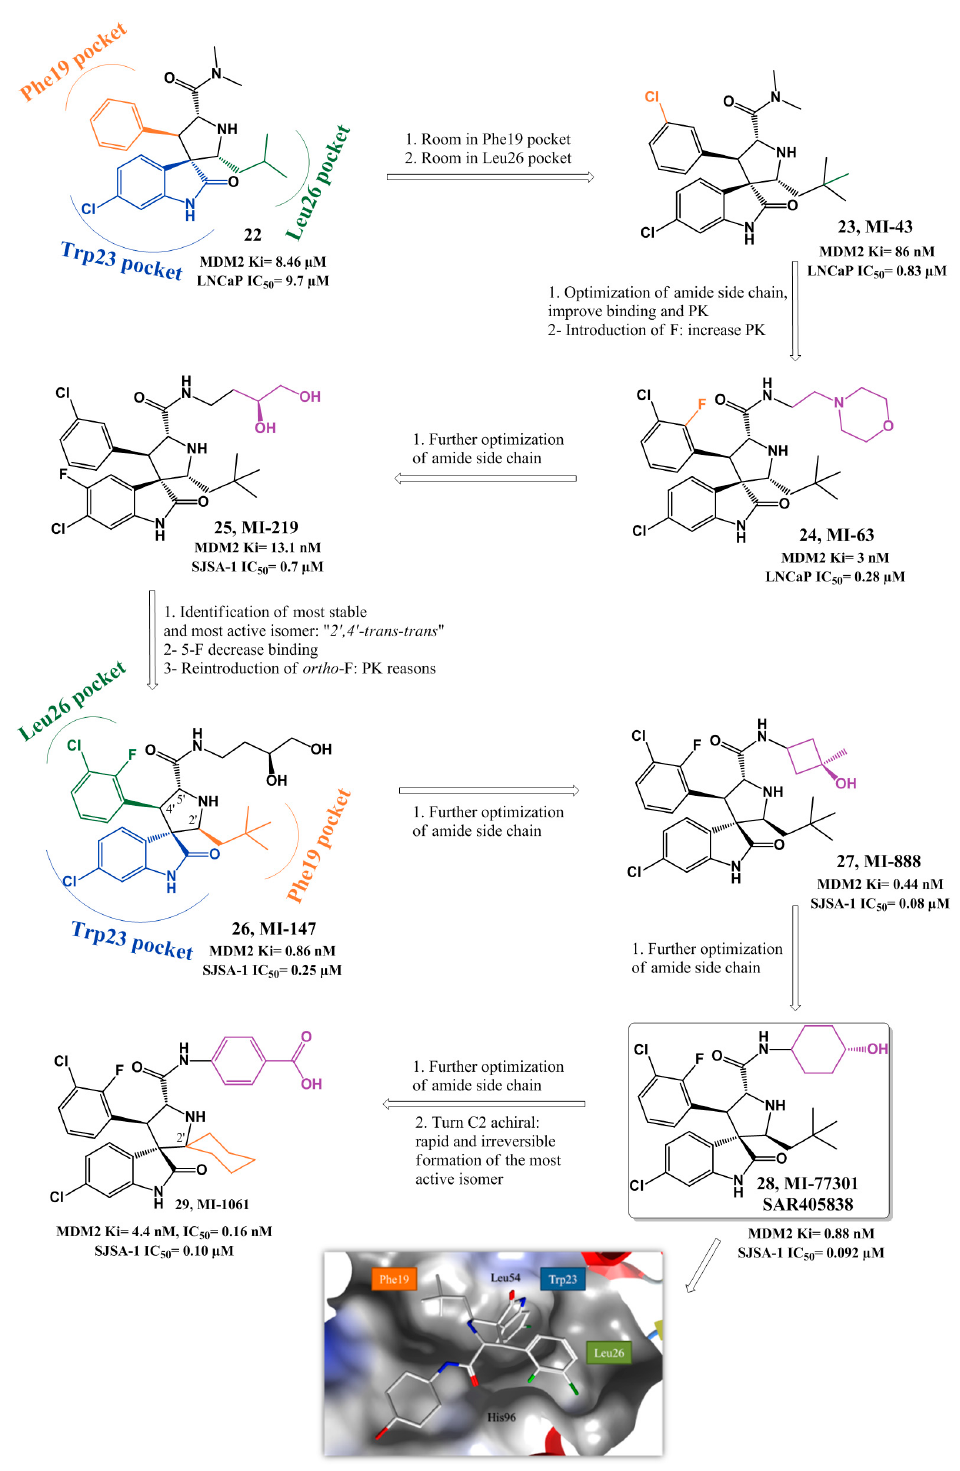
Figure 8. Spiropyrrolidine scaffold optimization. Docking pose of compound 28 in MDM2 (PDB 3LBL). MDM2 surface is colored in blue for hydrophilic areas and grey for hydrophobic areas. Compound 28 is depicted in stick model and is colored according to element type: white for carbon atoms, blue for nitrogen atoms, red for oxygen atoms, bright green for fluorine, and dark green for chlorine atoms.